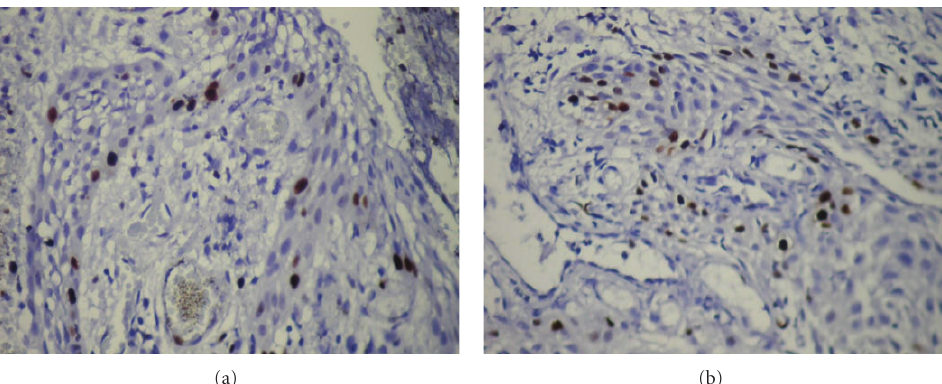
Figure 8: (a) The expressions of Ki-67 in epithelium of dentigerous cysts (Ki-67 × 40). (b) The expressions of MCM-2 in epithelium of dentigerous cysts (MCM-2 × 40).